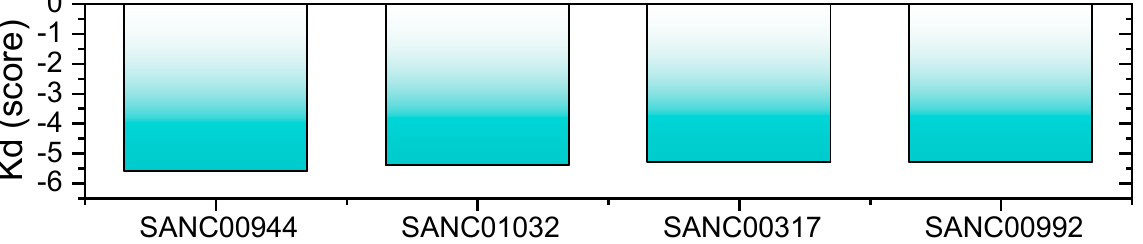
Figure 11. Dissociation constant (K D ) predicted by prodigy-LIG for the SANC00944–RBD, SANC01032–RBD, SANC00992–RBD, and SANC00317–RBD complexes.